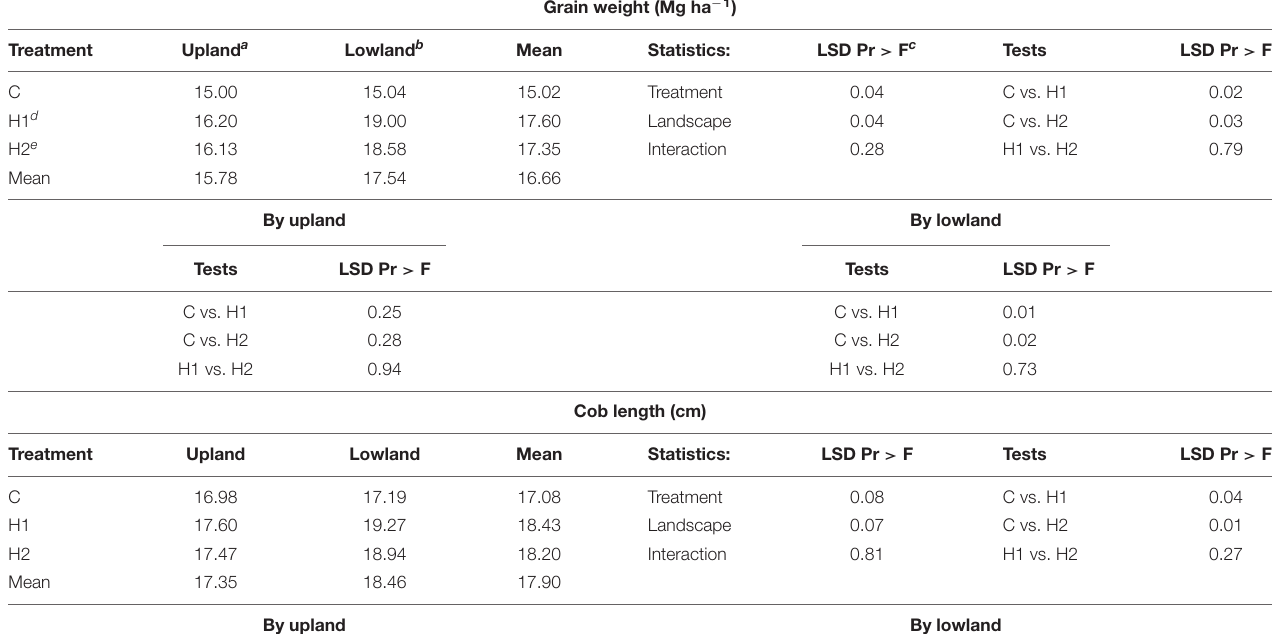
Grain weight (Mg ha − 1 )